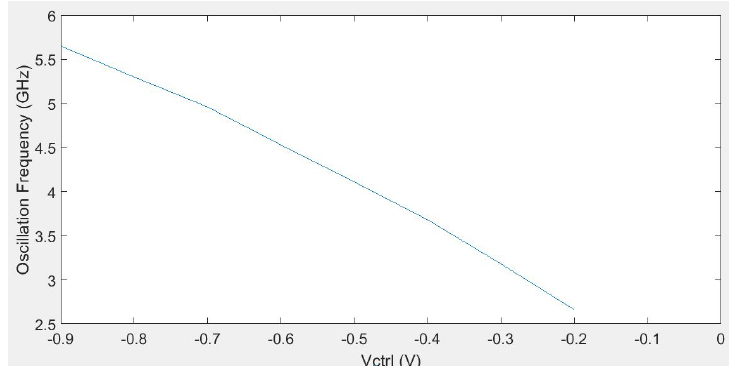
Figure 9. VCO response when V ctrl = − 0.9 V and f osc = 5.65 GHz.